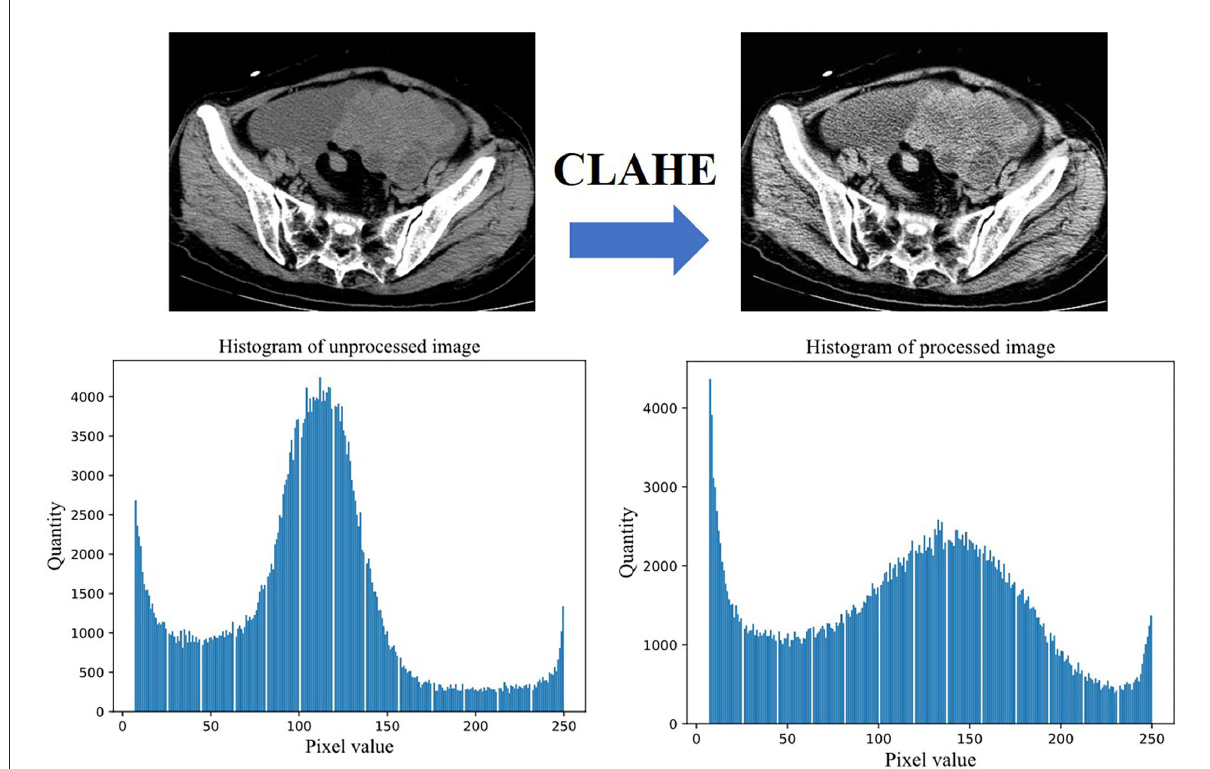
FIGURE3 Effect and pixel histogram before and after image enhancement.